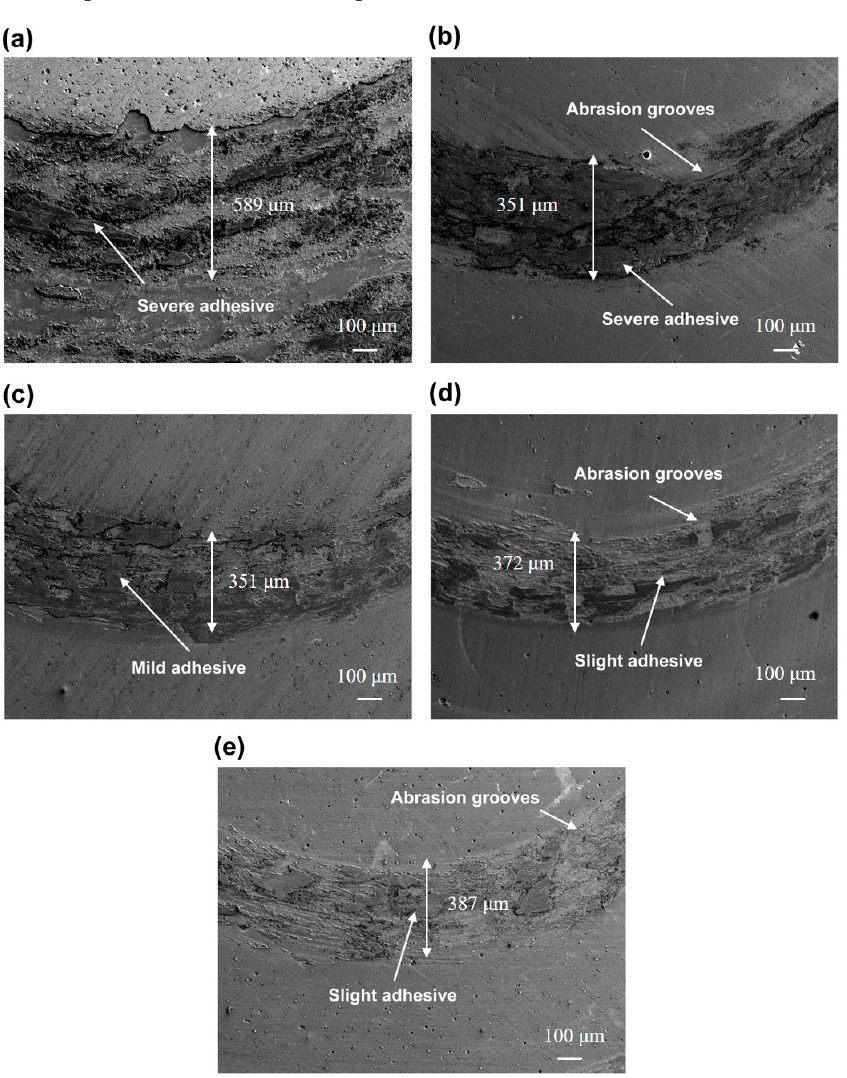
Figure 6. SEM images of worn CrAgCeN coatings deposited at different pressures: ( a ) 0.4 Pa, ( b ) 0.5 Pa, ( c ) 0.6 Pa, ( d ) 0.7 Pa and ( e ) 0.8 Pa. ( b ) 0.5 Pa, ( c ) 0.6 Pa, ( d ) 0.7 Pa and ( e ) 0.8